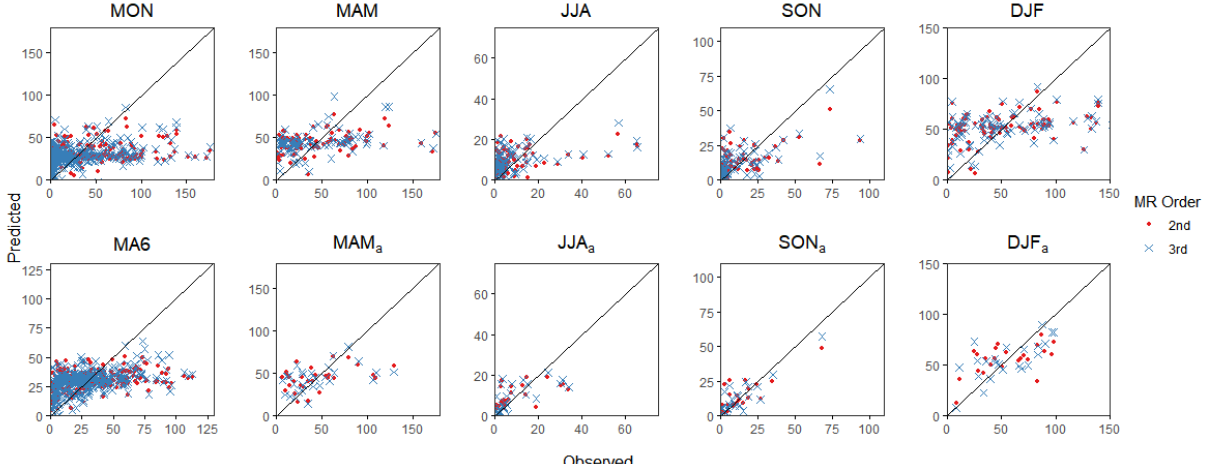
Figure 4. Scatterplots between the predicted (using second- and third-order MR models with Niño 3.4 and DMI as predictors) and the observed Q 50 for Madiun River (Ma) in all temporal variants: monthly (MON), six-month moving average (MA6), monthly seasonal (MAM-DJF), and averaged monthly seasonal (MAM a -DJF a ).